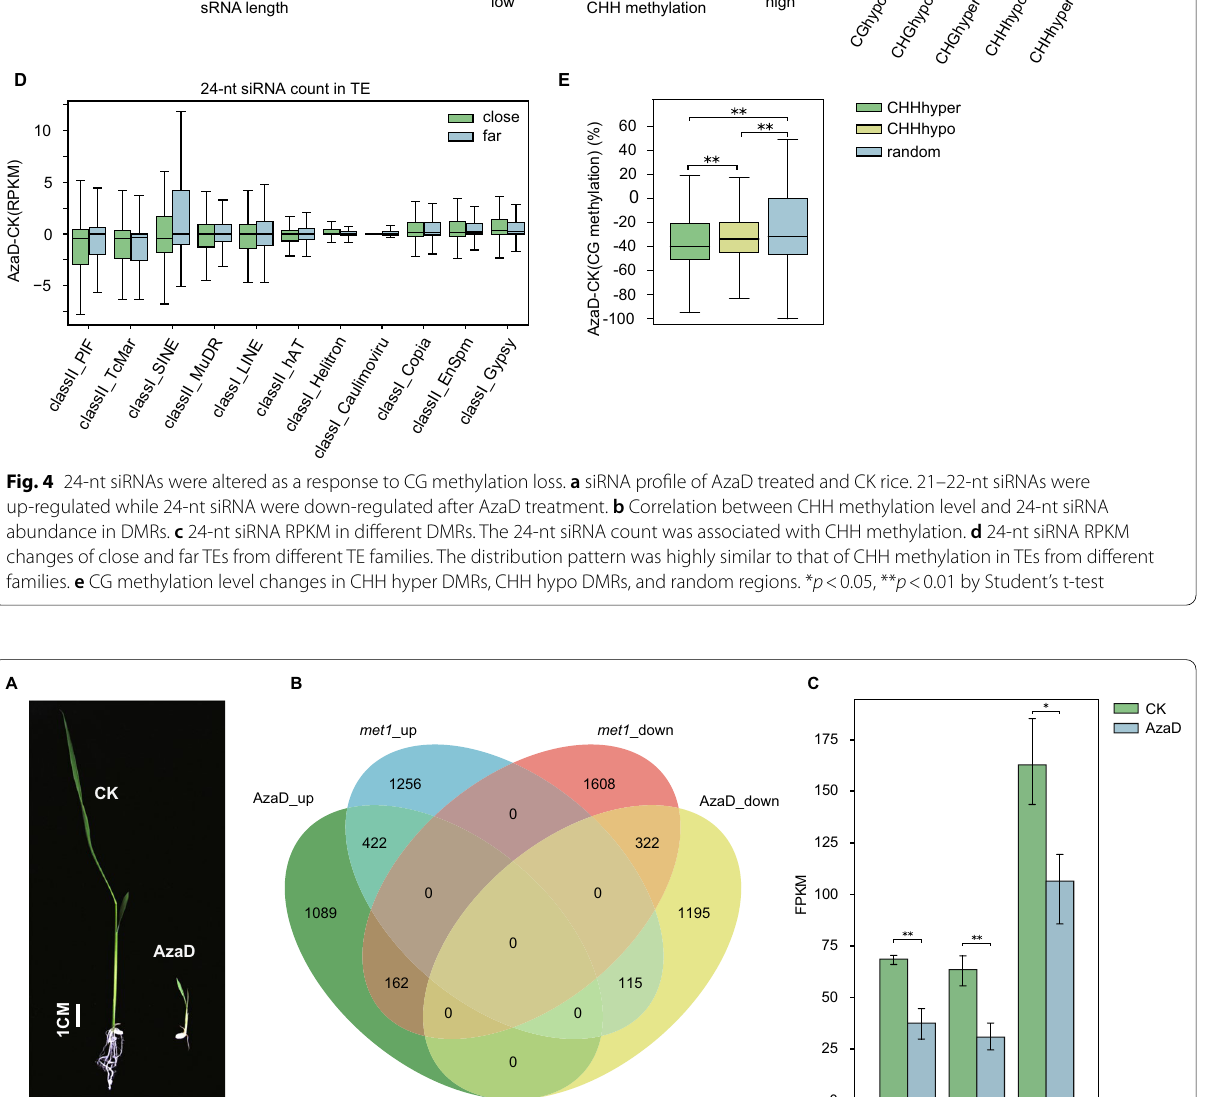
1 cm. b Venn diagrams show =